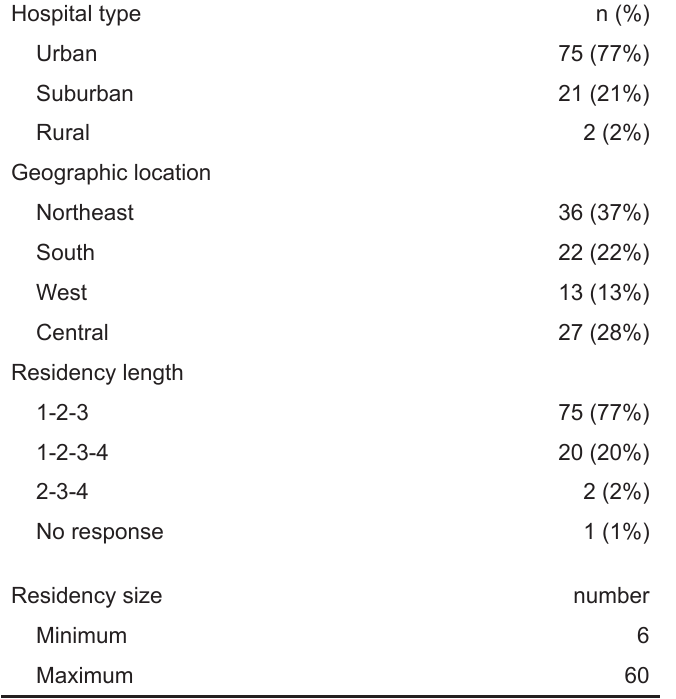
Table 1. Demographics of programs responding to survey.